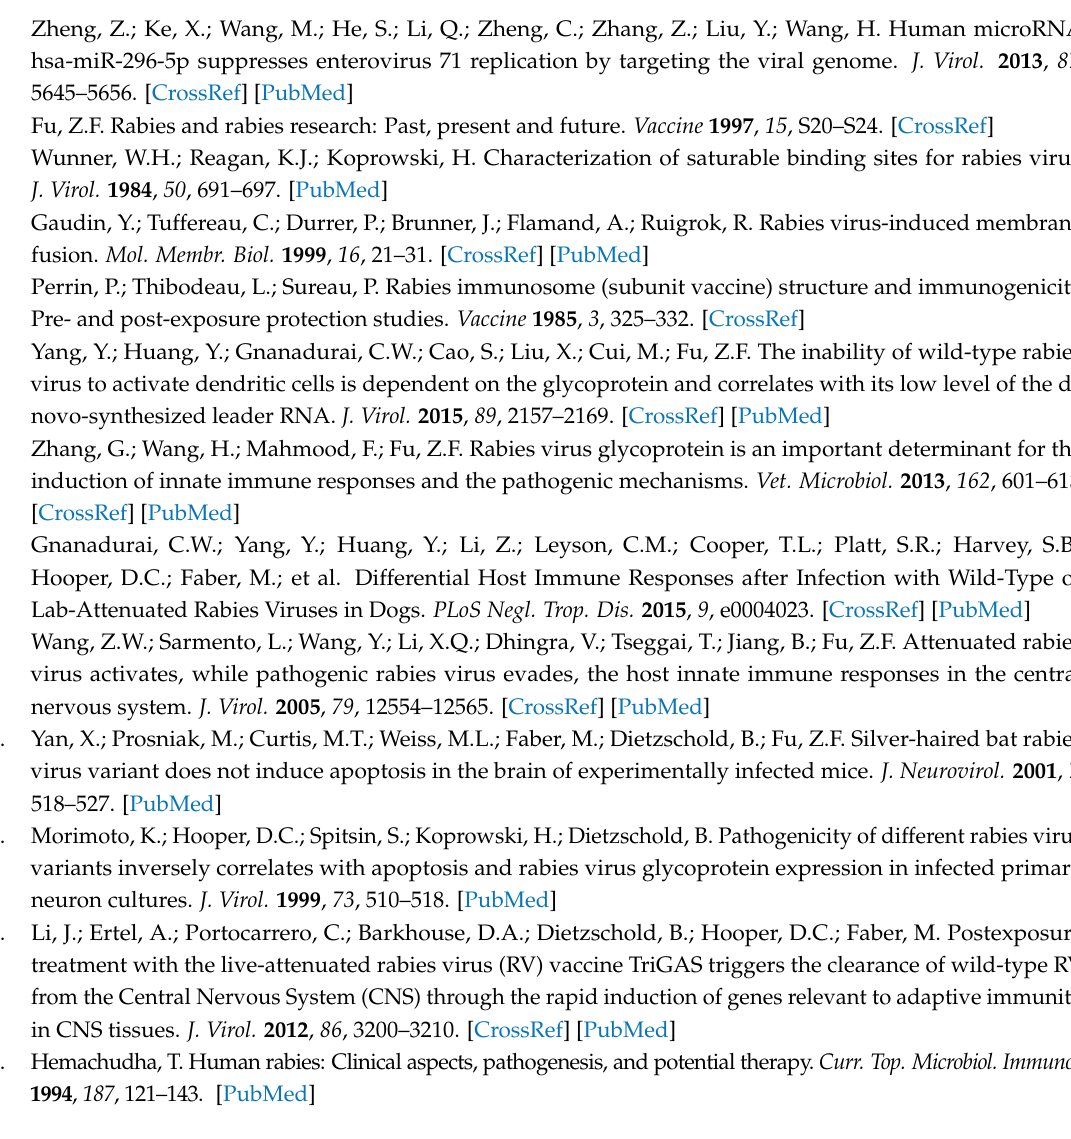
Figure S1: In vitro translation of different RABV-G and their binding affinities to anti-G